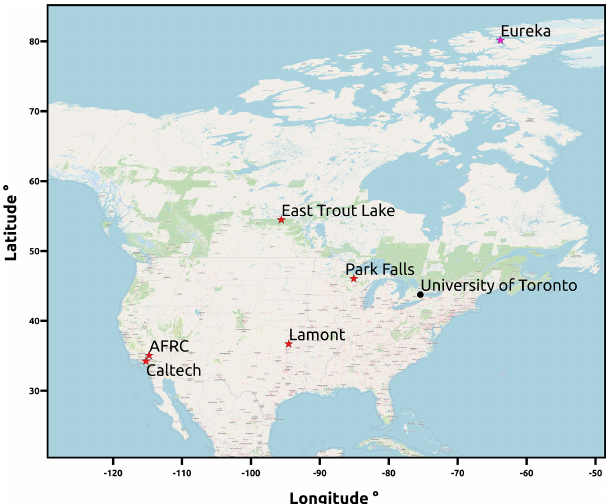
Figure 1. TCCON sites visited during the summer 2018 campaign are indicated by red stars located at Caltech (ci), AFRC (df), Lam- ont (oc), Park Falls (oc), and East Trout Lake (et). The magenta star indicates the Arctic site at Eureka (eu) that was visited in spring and summer of 2020. Long-term EM27/SUN measurements at the Uni- versity of Toronto (black circle) have been used for post-retrieval corrections. The map is generated using an OpenStreetMap (OSM) with Eckert III projection. © OpenStreetMap contributors